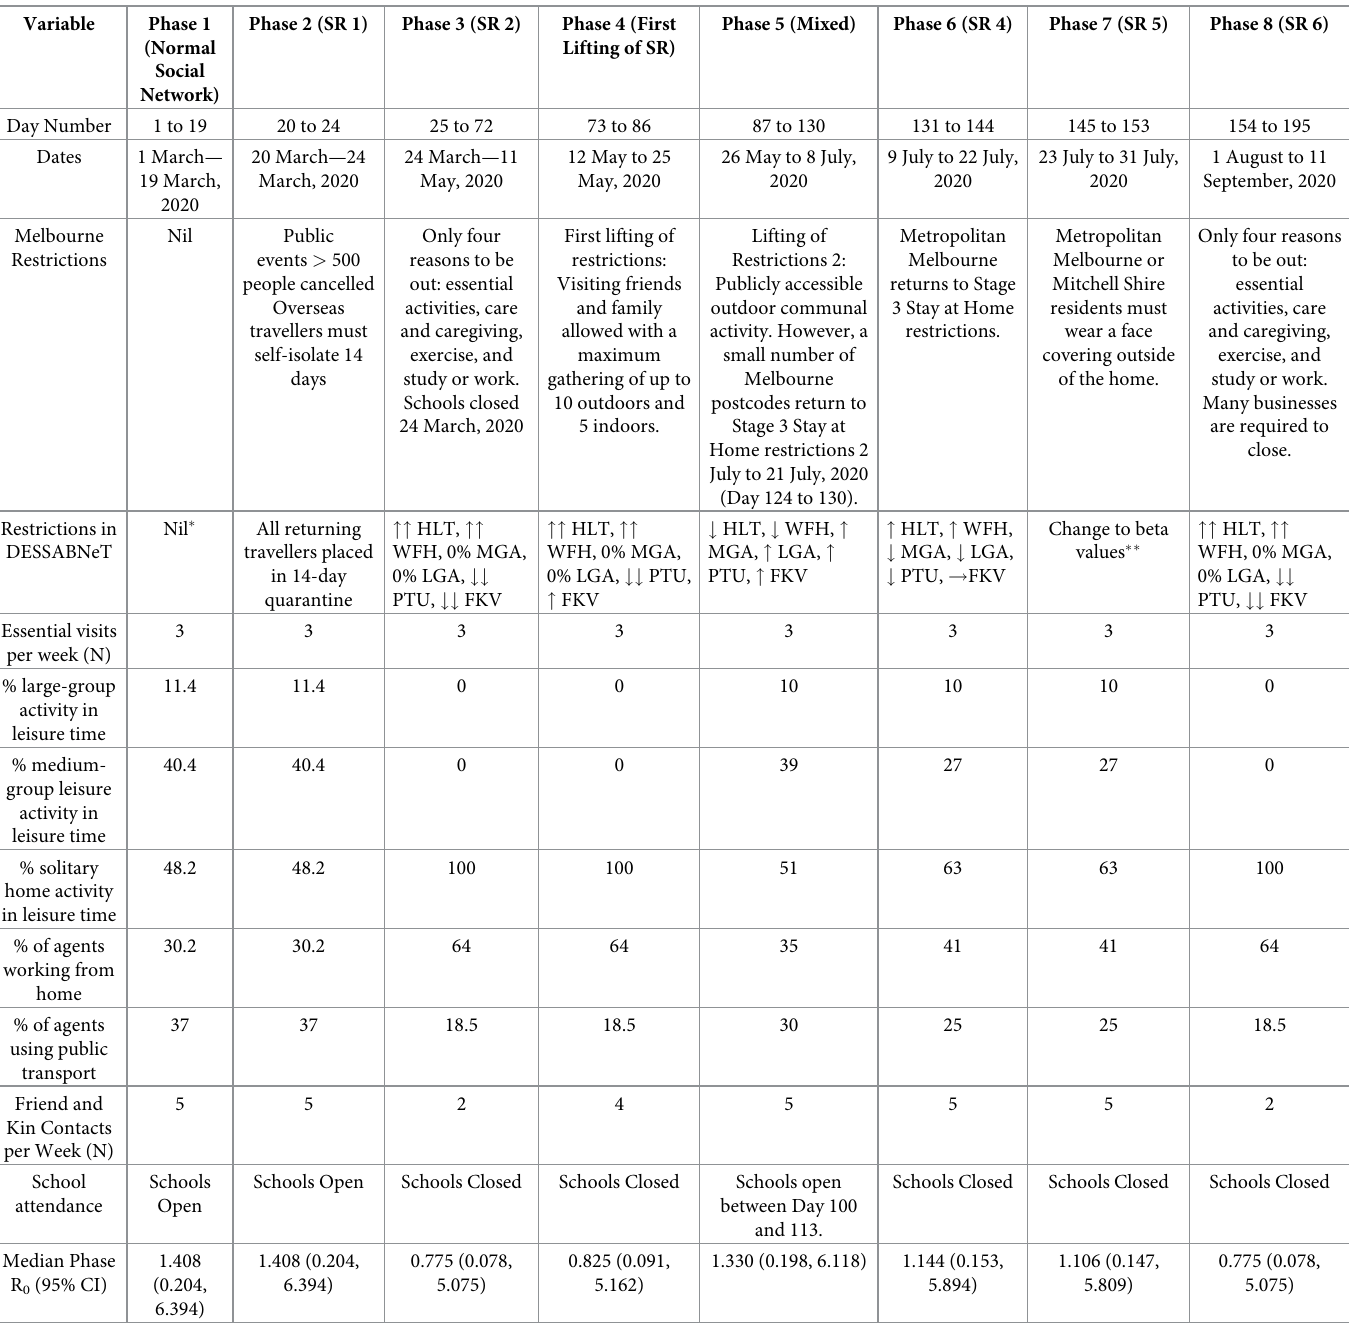
Table 4. Social restrictions for the simulation of two Melbourne